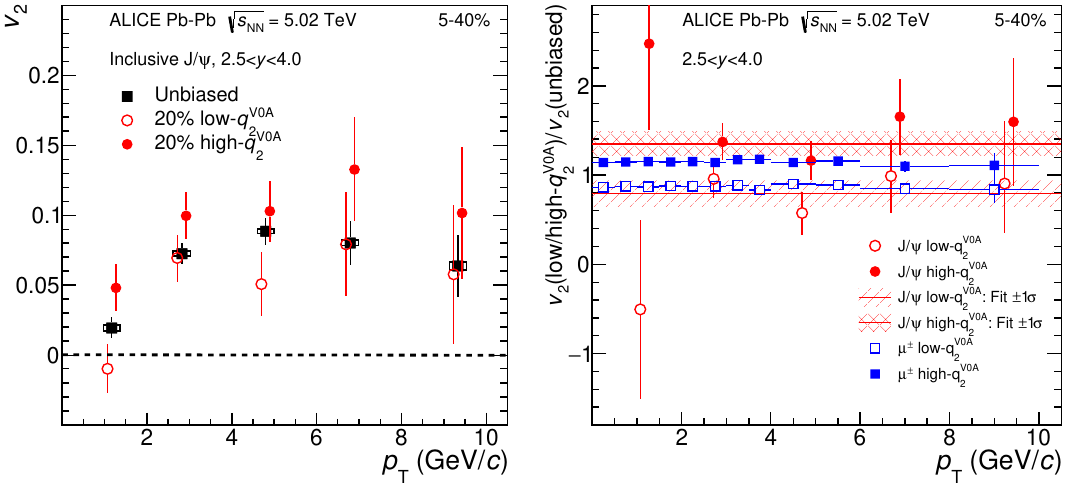
Figure 7 . (Color online) Left: the J/ v 2 as a function of p T for shape selected and unbiased samples in the 5{40% centrality interval in Pb-Pb collisions at shifted along the horizontal axis for better visibility. Statistical and systematic uncertainties are shown as bars and boxes, respectively. Right: ratio of the J/ v 2 in lowest and highest q V0A shape classes and the unbiased sample. The shaded bands represent the result with a constant function (cid:6) 1 (cid:27) . The J/ results are compared to the ratios for the single muons v 2 obtained with the same event-shape